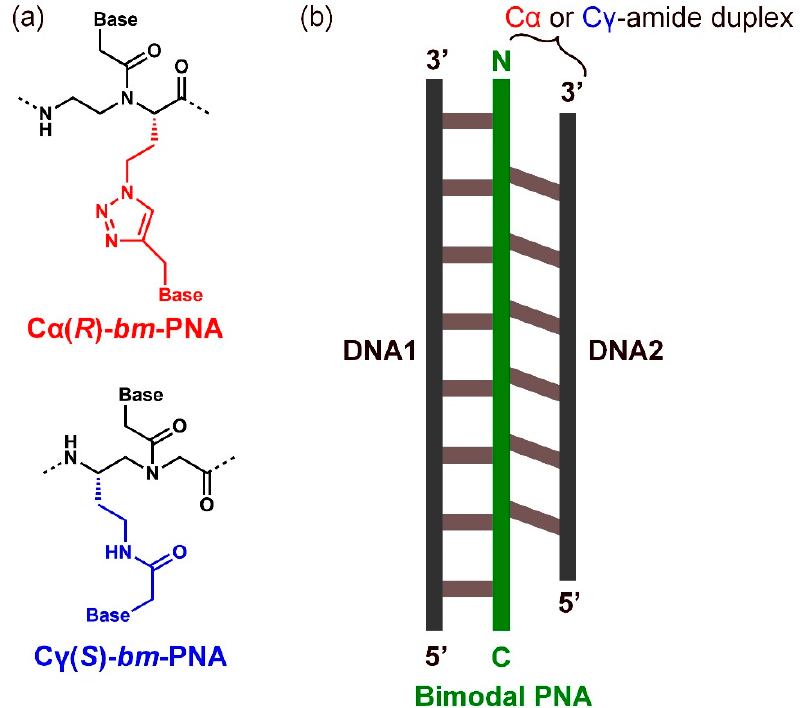
Figure 11. ( a ) Chemical structures of C α and C γ - bm -PNAs. ( b ) bm -PNA recognizes two DNA strands forming a double duplex.